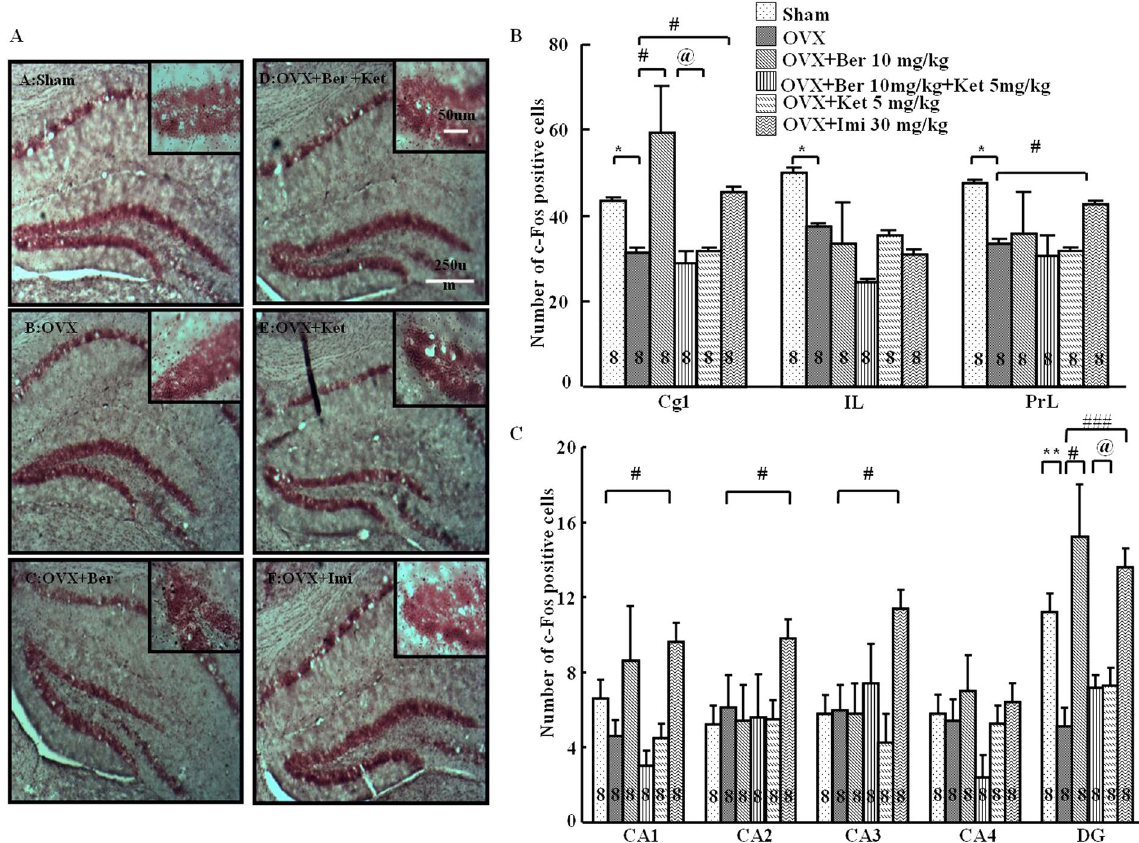
Figure 7. c-Fos-positive cells in frontal cortex and hippocampus. ( A ) Representative sections through the dentate gyrus (inset: greater magnification near the tip of the dentate), showing c-Fos stained cells (dense brown nuclear staining) and counterstaining with neutral red. ( B ) The number of c-Fos positive cells in the subregions of the frontal cortex: cingulate cortex (Cg1), infralimbic cortex (IL), and prelimbic cortex (PrL). ( C ) The number of c-Fos positive cells in the subregions of the hippocampus: cornu ammonis 1–4 (CA1-CA4) and dentate gyrus (DG). Group conditions are indicated by the following letters and abbreviations: ( A ) Sham, sham treatment; ( B ) OVX, ovariectomy only; ( C ) OVX + Ber, ovariectomy and berberine, 10 mg/kg; ( D ) OVX + Ber + Ket, ovariectomy, berberine, 10 mg/kg, and ketanserin, 5 mg/kg; ( E ) OVX + Ket, ovariectomy and ketanserin, 5 mg/kg); and ( F ) OVX + Imi, ovariectomy and imipramine, 30 mg/kg. Symbols